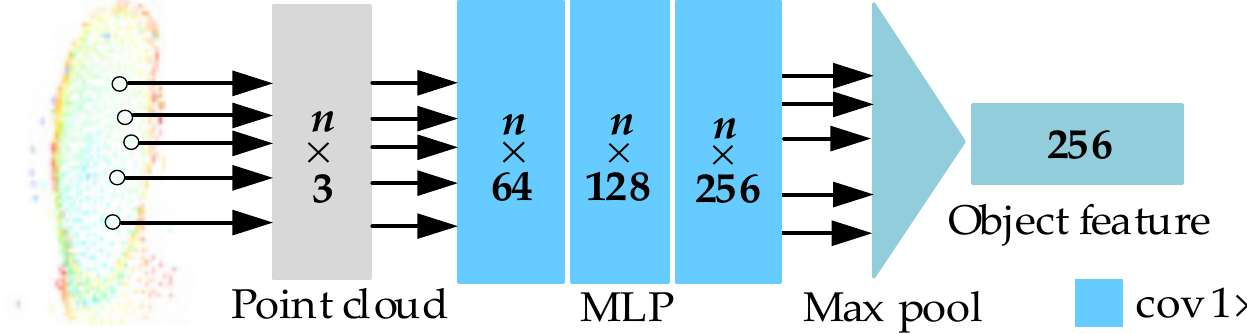
Figure 1. The structure of PointNet for extracting features of the point object. The MLP consists of three convolutional layers with filters 64, 128, and 256. The convolution kernel is 1 1 × .